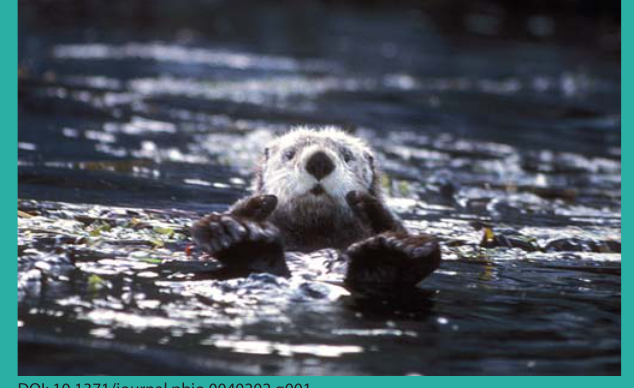
Figure 1. Sea Otters